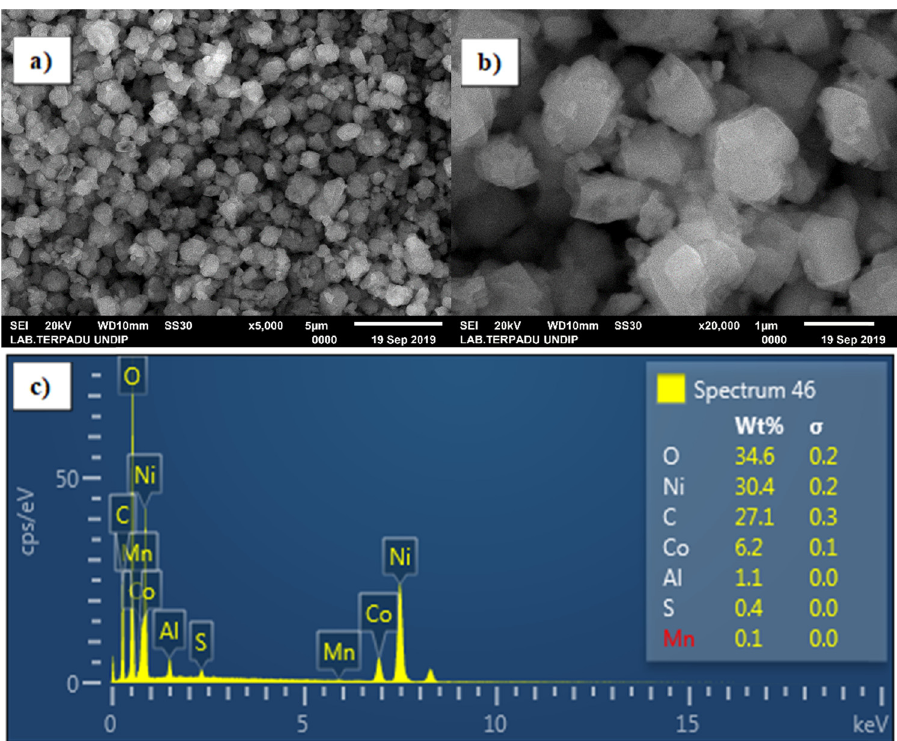
Figure 2: SEM images and EDX analysis of NCA - oxalate ( a ) – ( c )